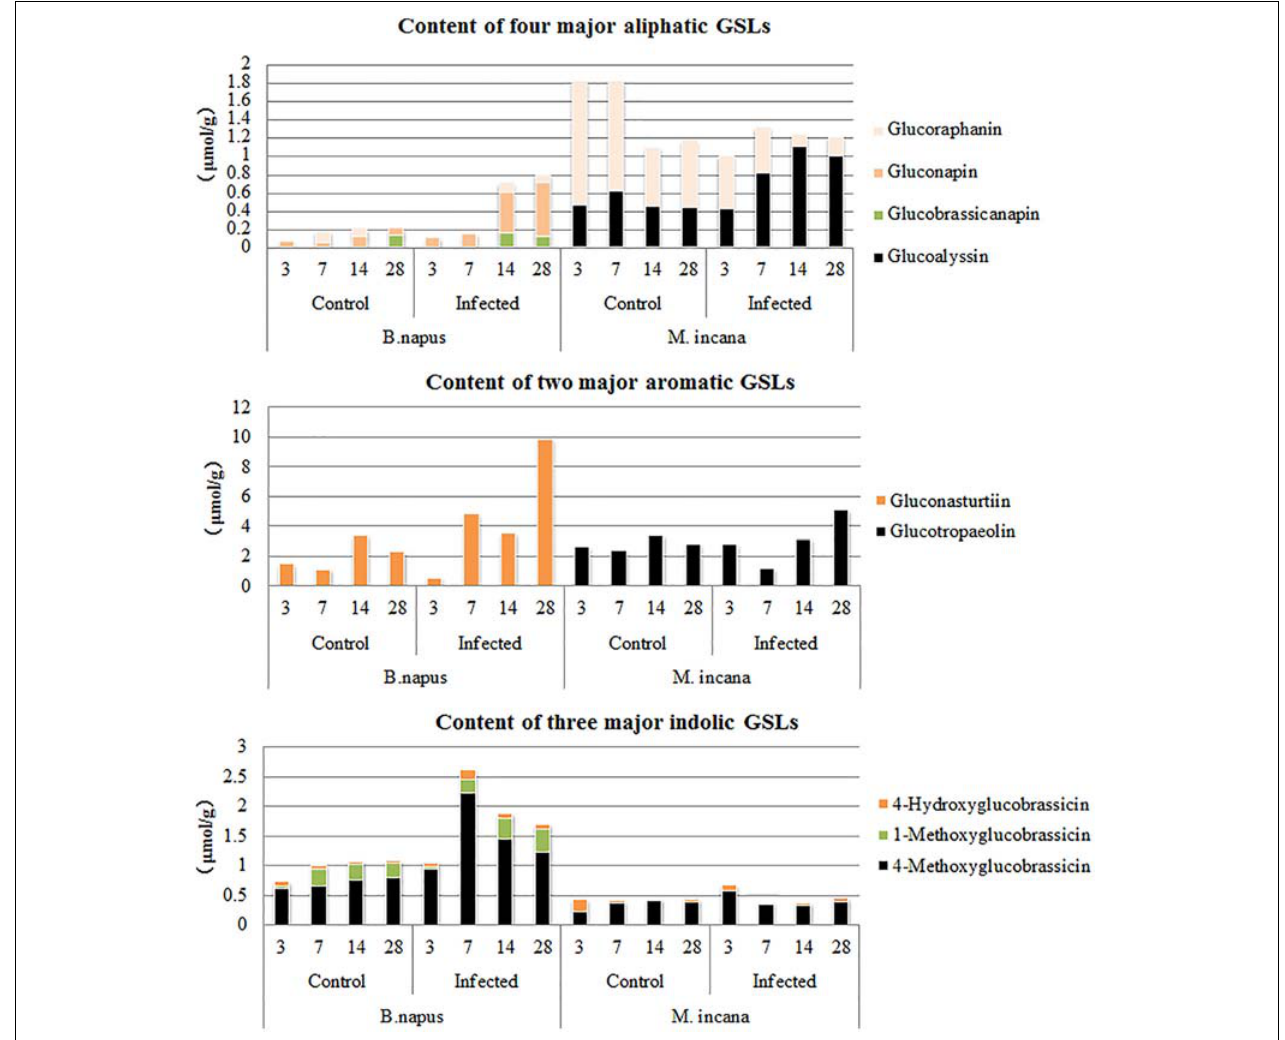
FIGURE 6 | Major components of glucosinolates (GSLs) in the roots of B. napus and M. incana at 3, 7, 14, and 28 days after inoculation